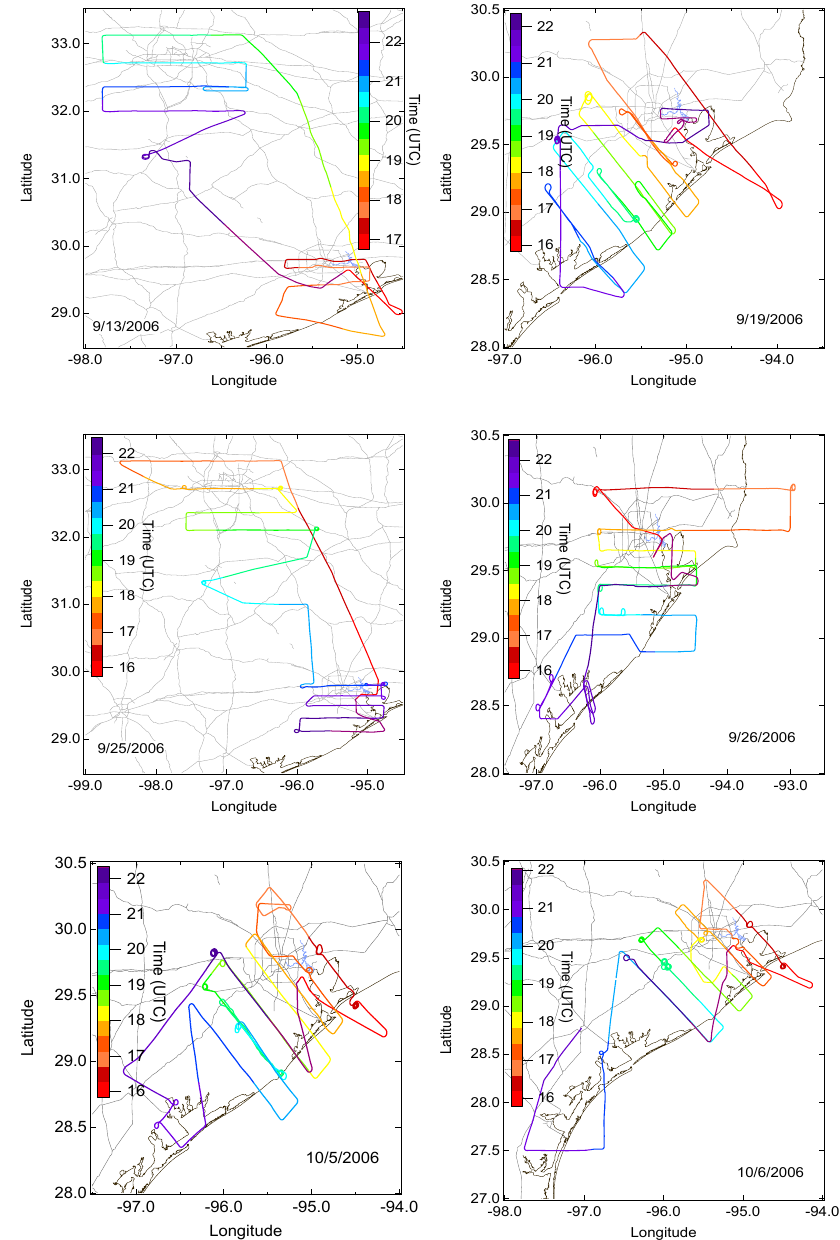
Figure 2. The flight paths of the NOAA-WP3 aircraft for selected days during TexAQS 2006. Color codes represent the flight times in UTC. 5 Urban areas are known to have large NO x emissions be- cause of mobile sources in both the on-road and non-road